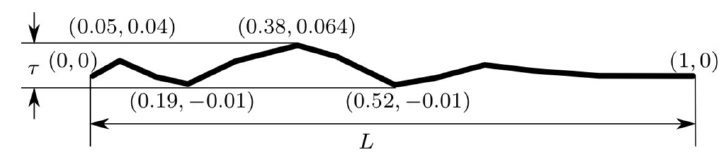
Figure 1. Profile of corrugated